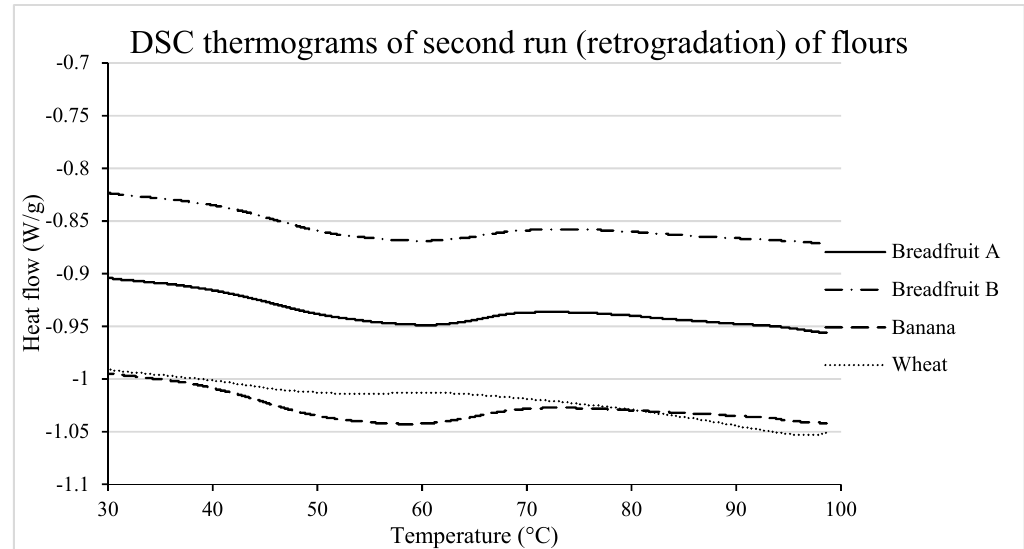
Figure 5. DSC thermograms (retrogradation) of tropical flours compared with a traditional flour. Treatments were flour types of breadfruit A, breadfruit B, banana, or wheat. Breadfruit flour A was sourced from Natural Foods International (Apia, Western Samoa). Breadfruit flour B was sourced from Jungle Project (Alajuela, Costa Rica). Banana flour was sourced from LiveKuna, Kunachia LLC (Davie, FL, USA). Wheat flour was obtained commercially from Bulk Barn Foods (Aurora, ON, Canada).